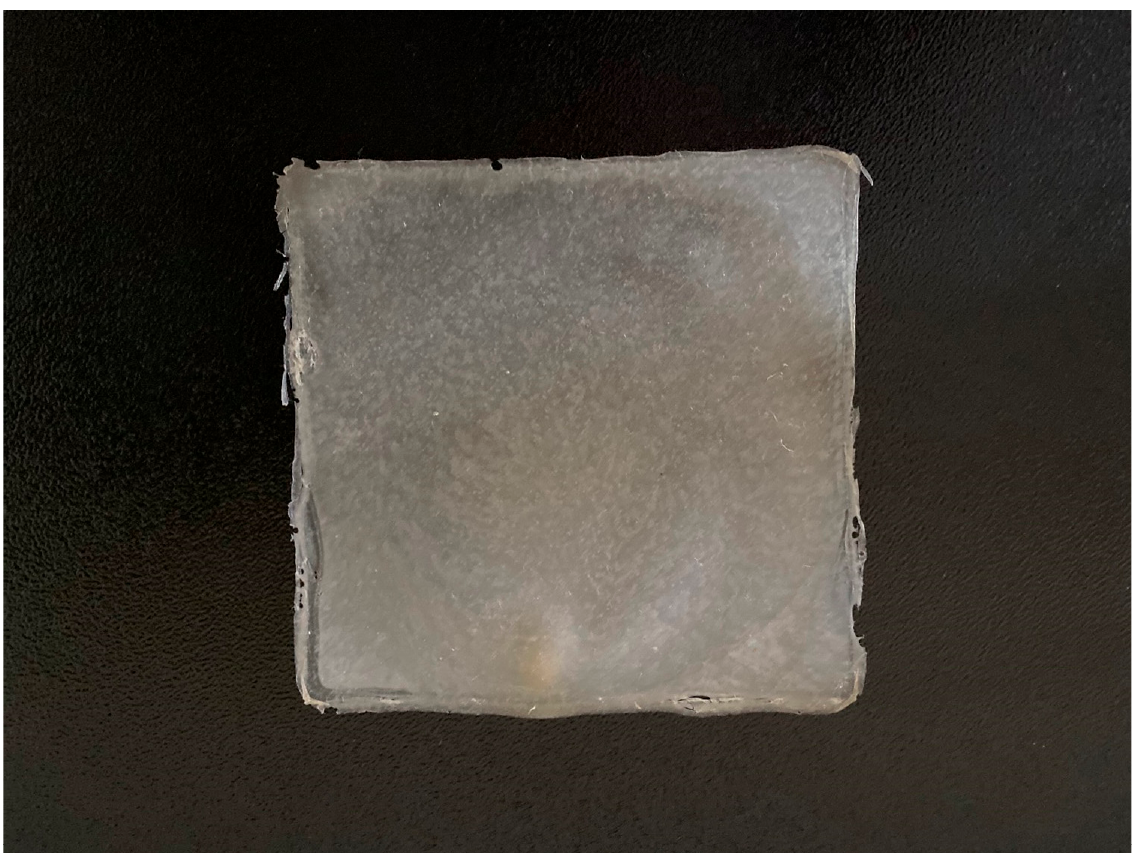
Figure 2. Microbial composite film, dimensions 16 cm (length) × 16 cm (width).